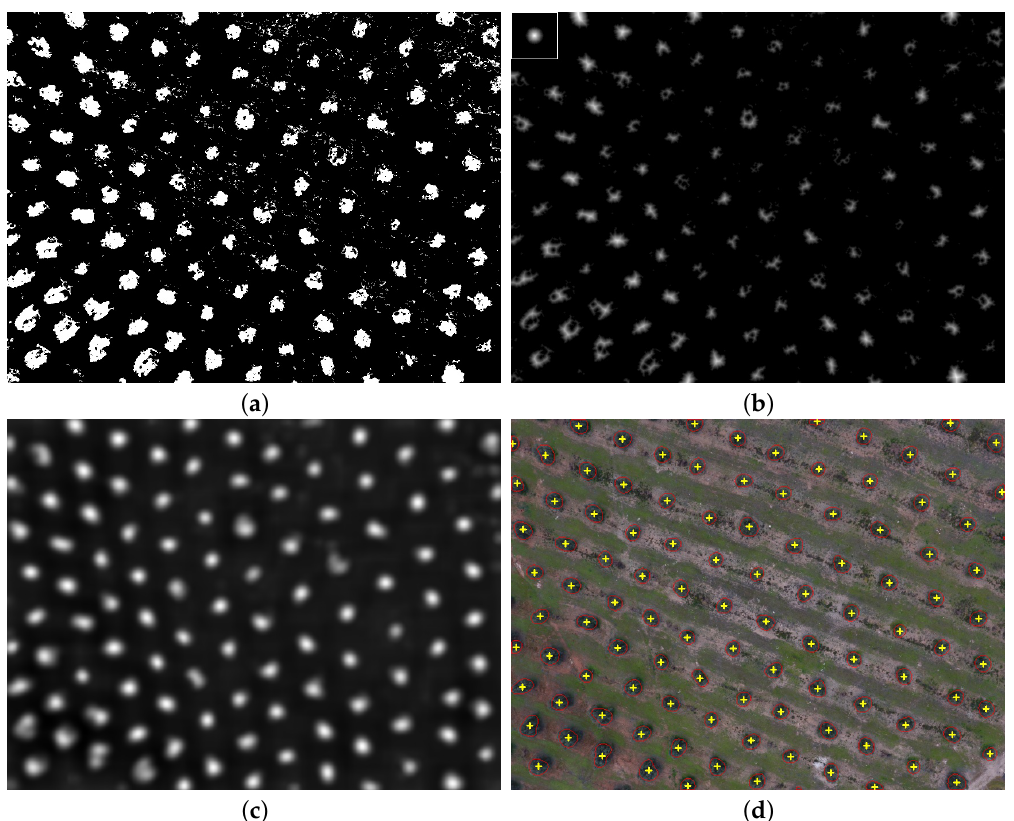
Figure 5. Images corresponding to the intermediate steps when applying the color-based segmentation algorithm to the image DJI_0225. ( a ) Color-based thresholding. ( b ) Distance transform and template (top left). ( c ) Template matching. ( d ) Detected